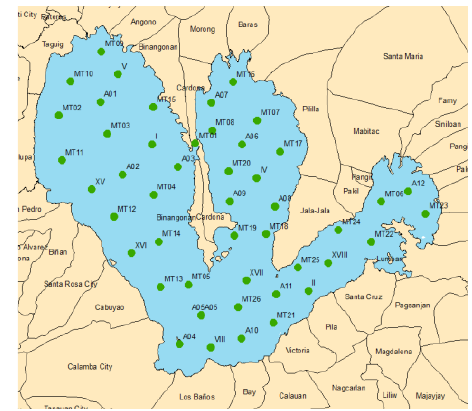
Figure 4. Field Validation Points for Laguna Lake (November